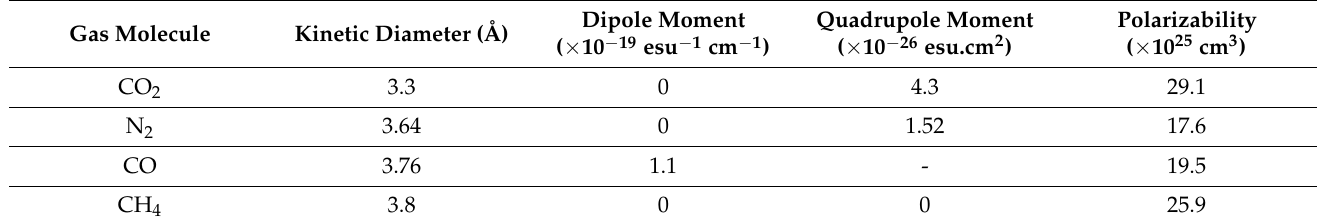
Table 10. Critical physical properties of gas molecules associated with the selective adsorption of CO 2 (Reprinted with permission from refs.